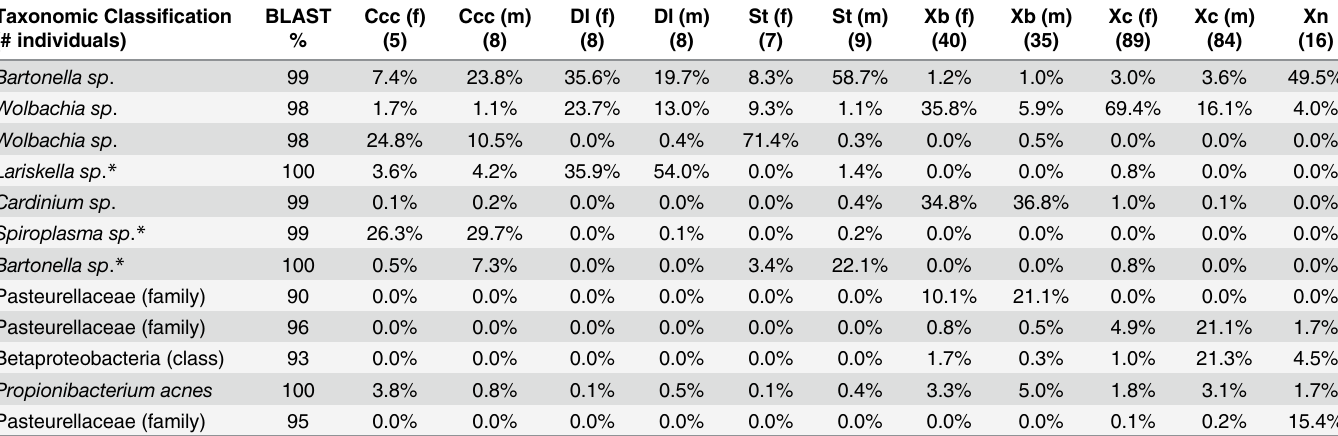
Fig 1. Average relative abundances of bacterial phyla within flea species. Proteobacteria were further divided based on Class: Alphaproteobacteria, Betaproteobacteria, and Gammaproteobacteria. Ccc: Ctenophthalmus calceatus cabirus , Dl: Dinopsyllus lypusus , St: Stivalius torvus , Xb: Xenopsylla brasiliensis , Xc: Xenopsylla cheopis , Xn: Xenopsylla nubica . Xenopsylla nubica were not sexed.